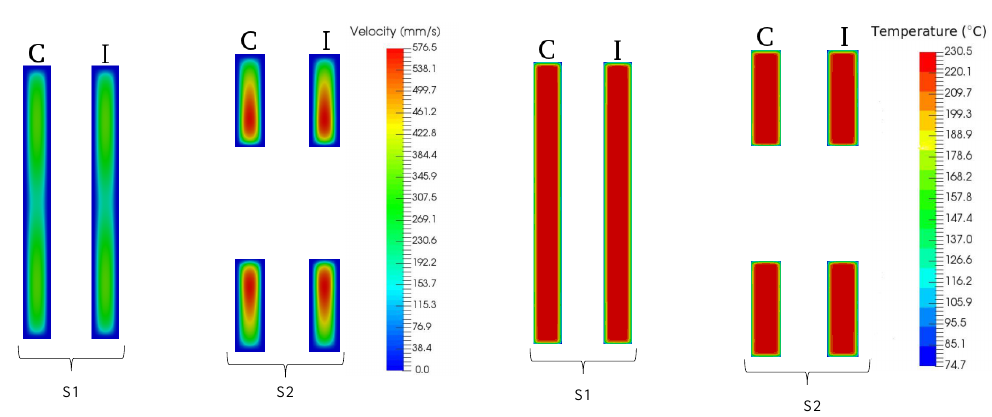
Figure 5. Velocity magnitude (left) and temperature (right) contours on slices S1 and S2 for Case Study 2. C, compressible formulation; I, incompressible